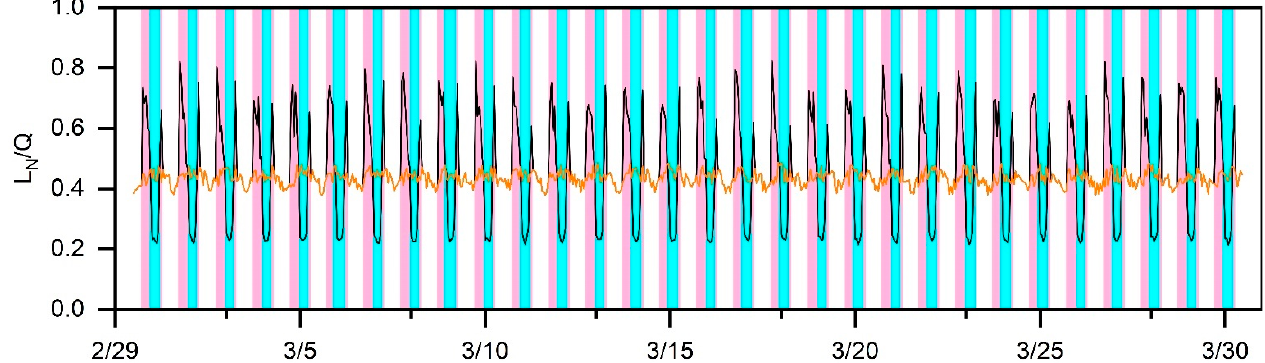
Figure 2. Temporal changes in L N from 1 March to 30 March, 2020 (UTC). The VOC-sensitive regimes were dominant in the morning and evening (shaded areas in pink) while P ( O 3 ) became more NO x -sensitive in the afternoon (shaded areas in cyan). The black line represents the values of L N and the yellow line represents the regime transition threshold.